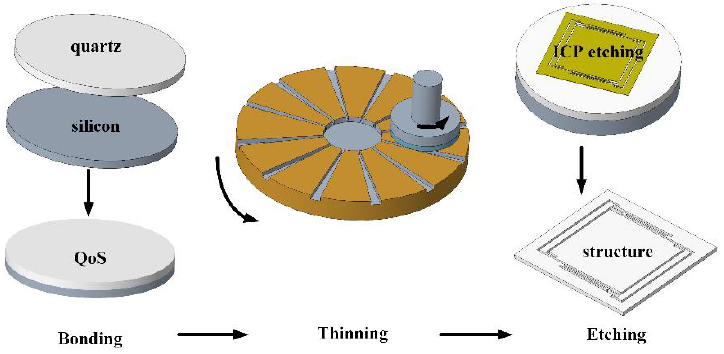
Figure 1. Schematic of the main fabrication process.